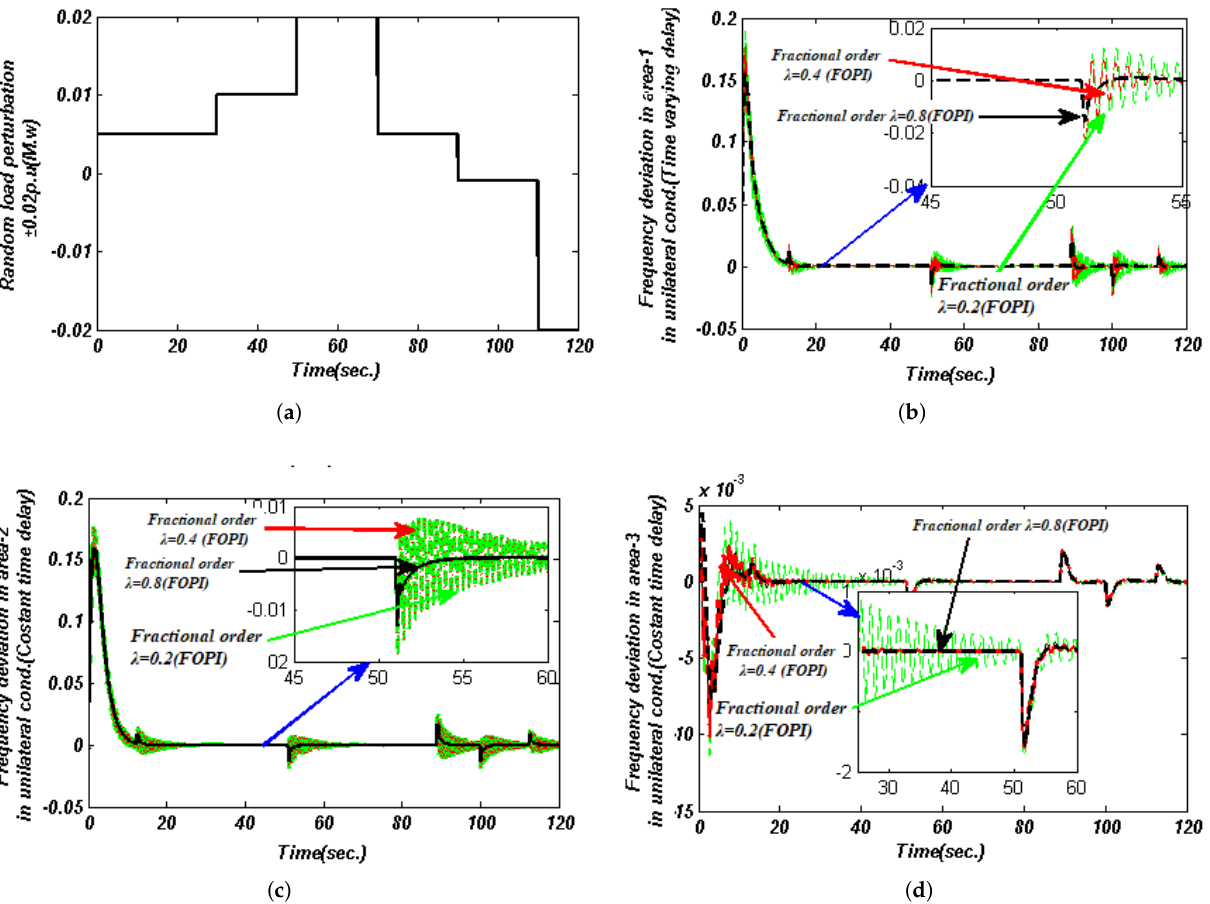
Figure 9. ( a ) Using a load of ± 0.02 p . u ., random load perturbation was performed (MW). ( b ) For a ± 0.02 ( p . u ) RLP type of load, frequency variation in area 1 in Hz for unilateral condition with time − varying ( τ d = 7.365 s ) ( µ = 0) delay. ( c ) For a ± 0.02 ( p . u ) RLP type of load, frequency variation in area 2 in Hz for unilateral condition with time − varying ( τ d = 7.365 s ) ( µ = 0) delay. ( d ) For a ± 0.02 ( p . u ) RLP type of load, frequency variation in area 3 in Hz for unilateral condition with constant time ( τ d = 5.127 s ) ( µ = 0)